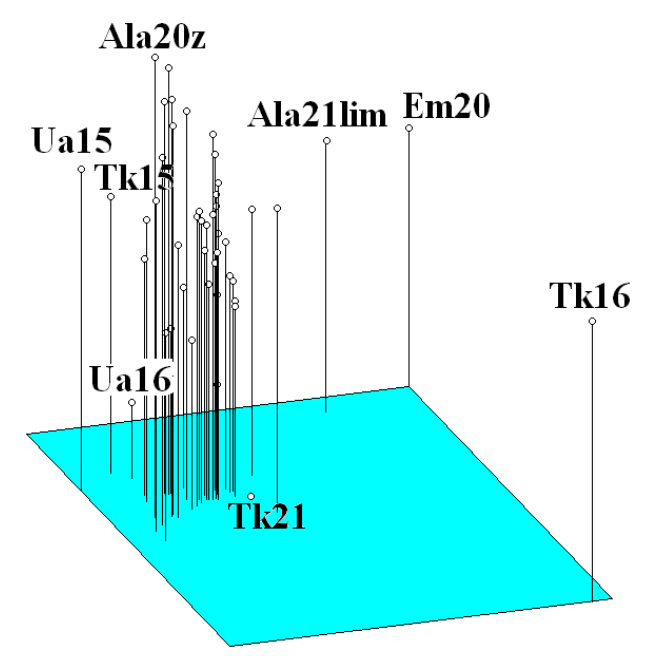
Figure 3. Position of samples from different rivers. Designations are given for the most deviating samples: Ala20z—Alakol Lake, estuary, 2020; Ala21lim—Alakol Lake, near Kabanbay settlement, wetland, 2021; Em20—Emel River 2020; Ua15 and Ua16—right side tributary of Tentek River in 2015 and 2016; Tk15, Tk16 and Tk21—Tentek River, depositional zone, 2015, 2016 and 2021. CCA was used to study possible relationships between five environmental varia- bles (turbidity, temperature, pH, ammonium and nitrate content) and fish abundance in the 47 samples (Table 2). Eigenvalues (lambda) were 0.466, 0.381, 0.197 and 0.116 for the first (horizontal), second (vertical), third and fourth axes, respectively. The first two axes explained 68.1% of the variance and all the canonical axes collectively explained 93.4% of variance. The sites/objects data were linearly related to the sites/variables data by re- sult of permutation test (500 permutations, F = 1.291, P = 0.030). The first axes reflected